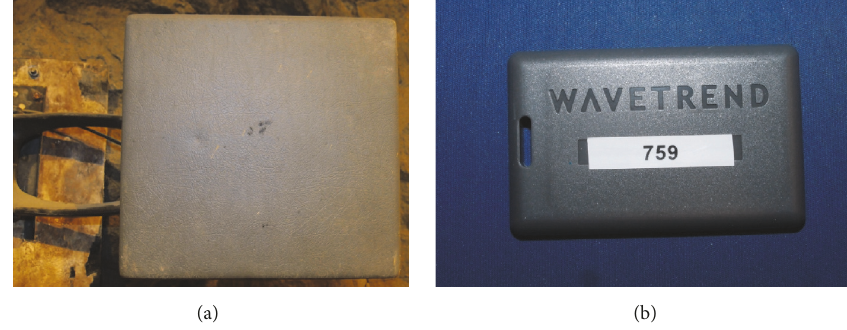
Figure 3: Directional antenna (a) and active ID card (b).